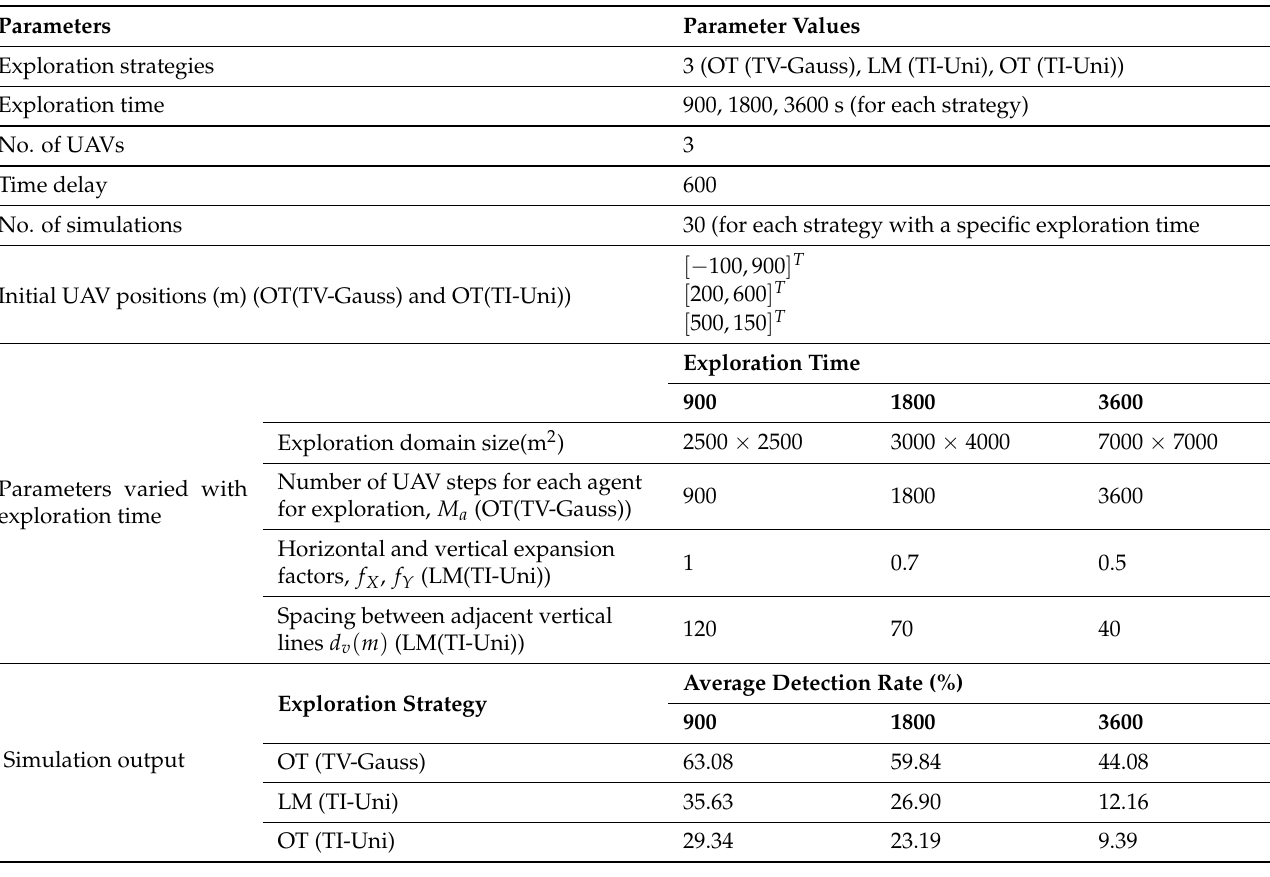
Table 2. Parameters for simulations performed for variation of exploration